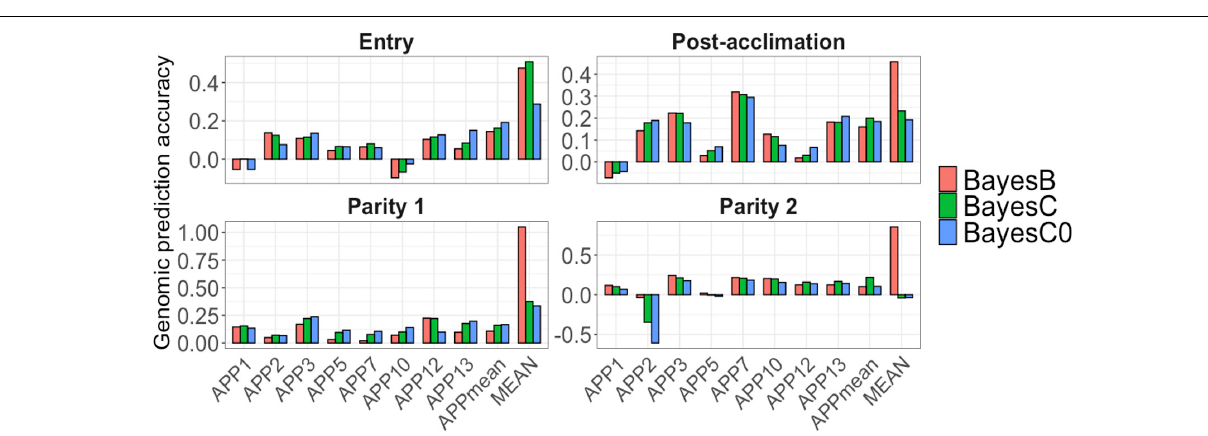
FIGURE 5 | Genomic prediction accuracies ( y -axis) for Actinobacillus pleuropneumoniae (APP1, 2, 3, 5, 7, 10, 12, and 13), average of all serotypes of APP (APP mean ), and average of antibody responses for all diseases (MEAN). The x -axis represents the different time-points of data collection. The colors correspond to the Bayesian method used. Note the different scales of y -axis for each time-point to enhance